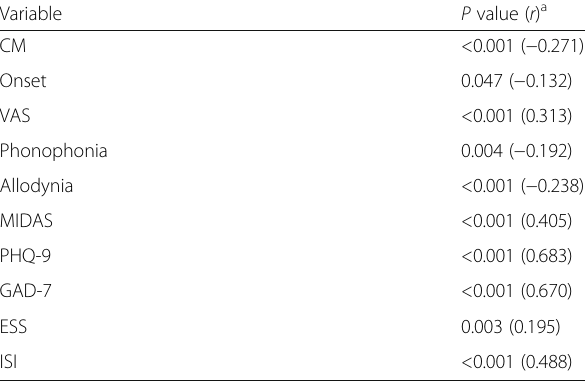
Table 3 Variables associated with the PSS score by univariate analyses in migraine patients